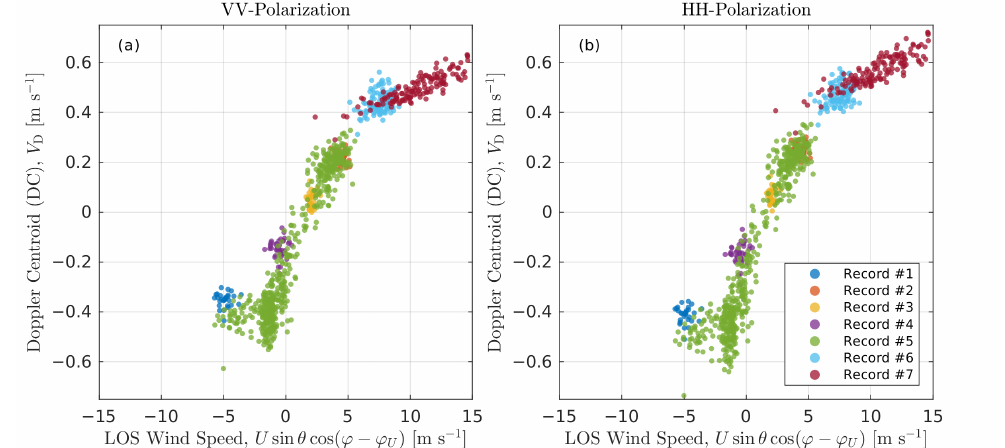
Figure 10. Measured Doppler centroid (DC) versus wind speed line-of-sight (LOS) projection. Colors indicate different records (see Figure